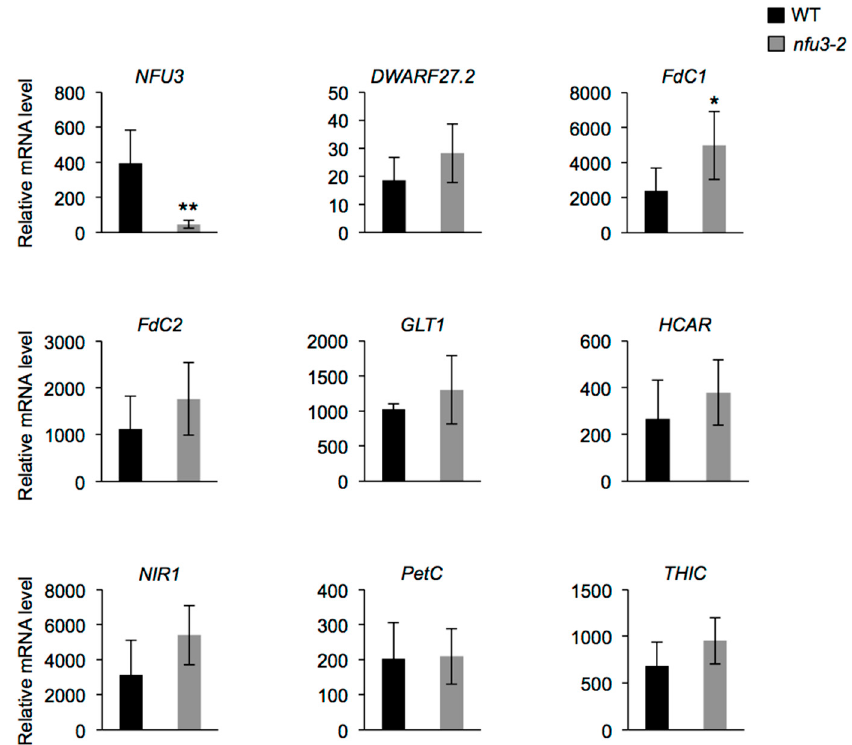
Figure 6. Analysis of DWARF27.2 , FdC1 , FdC2 , GLT1 , HCAR , NIR , PetC, and THIC gene expression in Arabidopsis thaliana wild type and nfu3-2 mutant. Analysis of DWARF27.2 , FdC1 , FdC2 , GLT1 , HCAR , NIR , PetC, and THIC gene expression in 2-week-old wild type and nfu3-2 Arabidopsis seedlings by qRT-PCR. t -test significant difference: * p < 0.05; ** p < 0.01. ( n = 6 technical repeats from three biological replicates from one representative experiment). Error bars show the means ± SD.